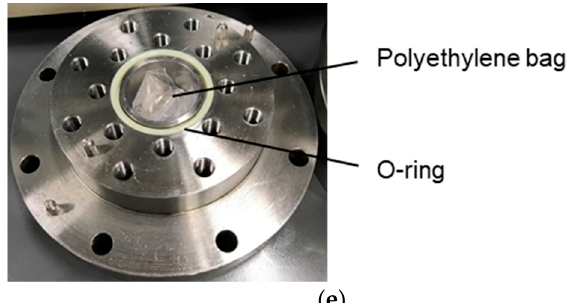
Figure 1. Device for applying High hydrostatic pressure (HHP) to NB1RGB cell suspension. ( a ) Overview of the device. ( b ) Cross-sectional view of the device. ( c ) Piston with five O-rings for applying HHP. ( d ) Polyethylene bag containing NB1RGB cell suspension. ( e ) Lower part of the device.